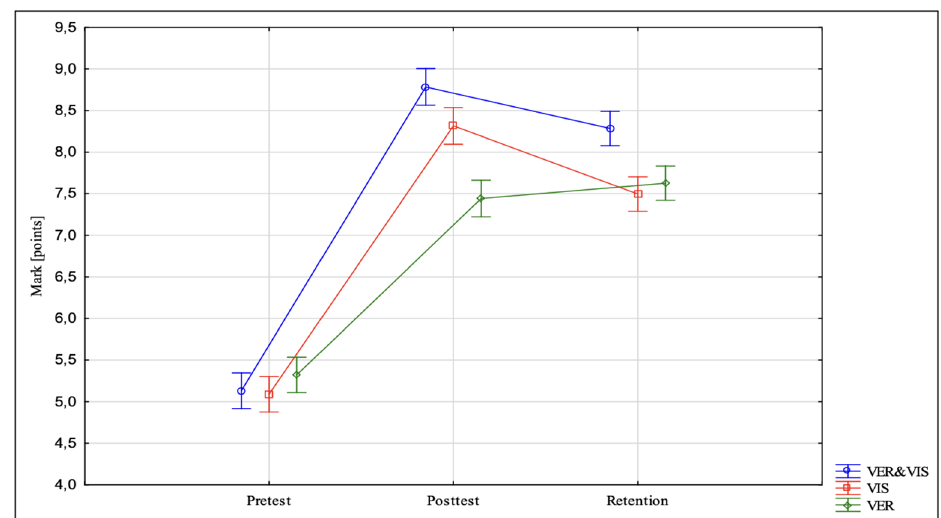
Figure 1. Point-based evaluation of motor task performance in all the groups with regard to time and type of feedback that influences the effectiveness of motor task learning. Based on a Tukey post-hoc test, the significance of differences between mean ratings of the judges at particular stages of the learning process was determined for groups VER&VIS, VIS and VER (Table 1). Table 1. Significance level of Tukey post-hoc test of experts’ ratings (PRET, POST, and RETT) in groups VER, VIS, and VER&VIS.